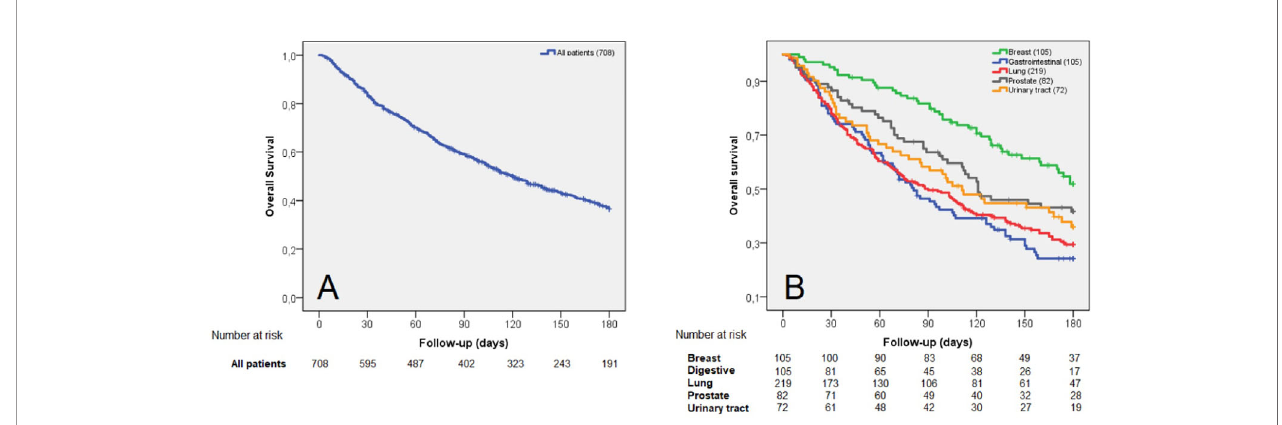
FIGURE 2 | Survival curves including: all patients (A) and the fi ve more prevalent primary tumors (B) .